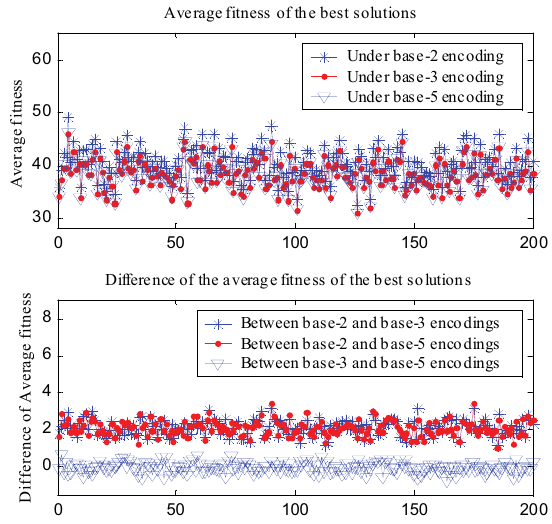
Fig. 3. The average fitness of the best solutions found in the 20 rounds of calculation for the fitness functions ( a i sin ( 2 π 2 i − 1 x + ϕ i )+ | a i | ) under the three encod- ∑ 51 i = 1 ings. The GA with the base-2 encoding significantly outperform the other